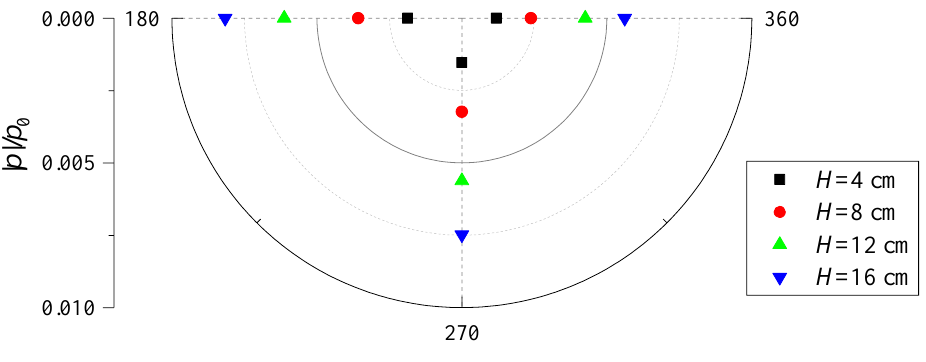
Figure 18. Distribution of the maximum pore-water pressures around the pile for various wave heights at z = − 0.70 m ( T = 2 s, Points 5, 9, and 7 in Figure 3).